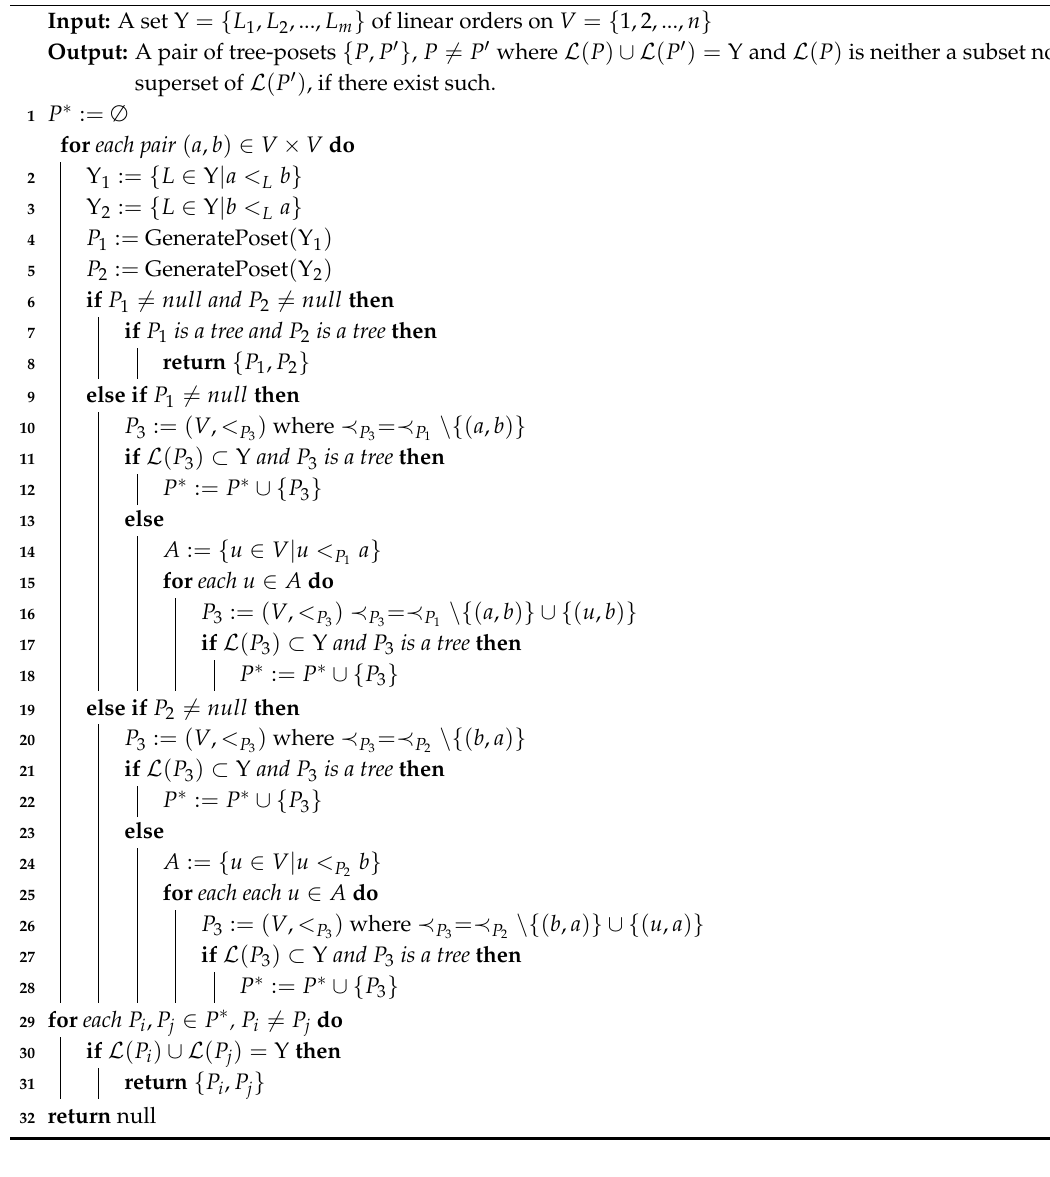
Algorithm 2: 2-Tree-Poset Cover